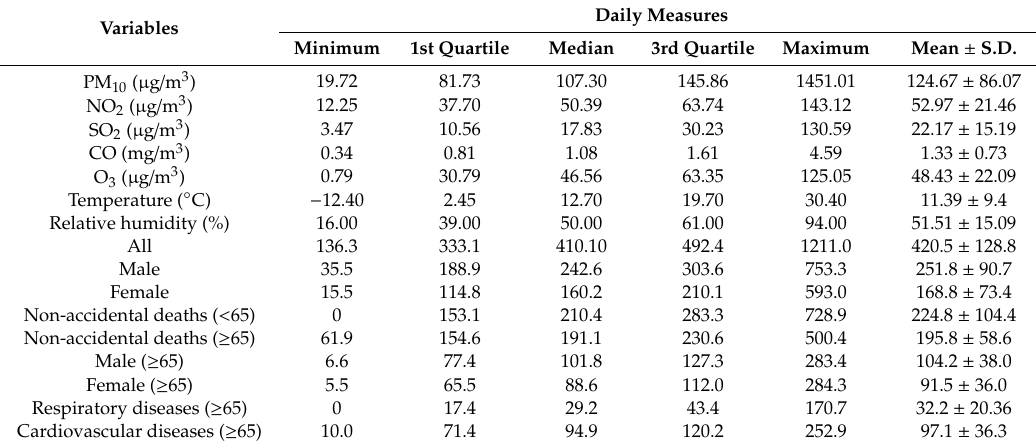
Table 1. Summary of statistics for air pollutants, weather variables, and YLL in Lanzhou, 2014–2017.